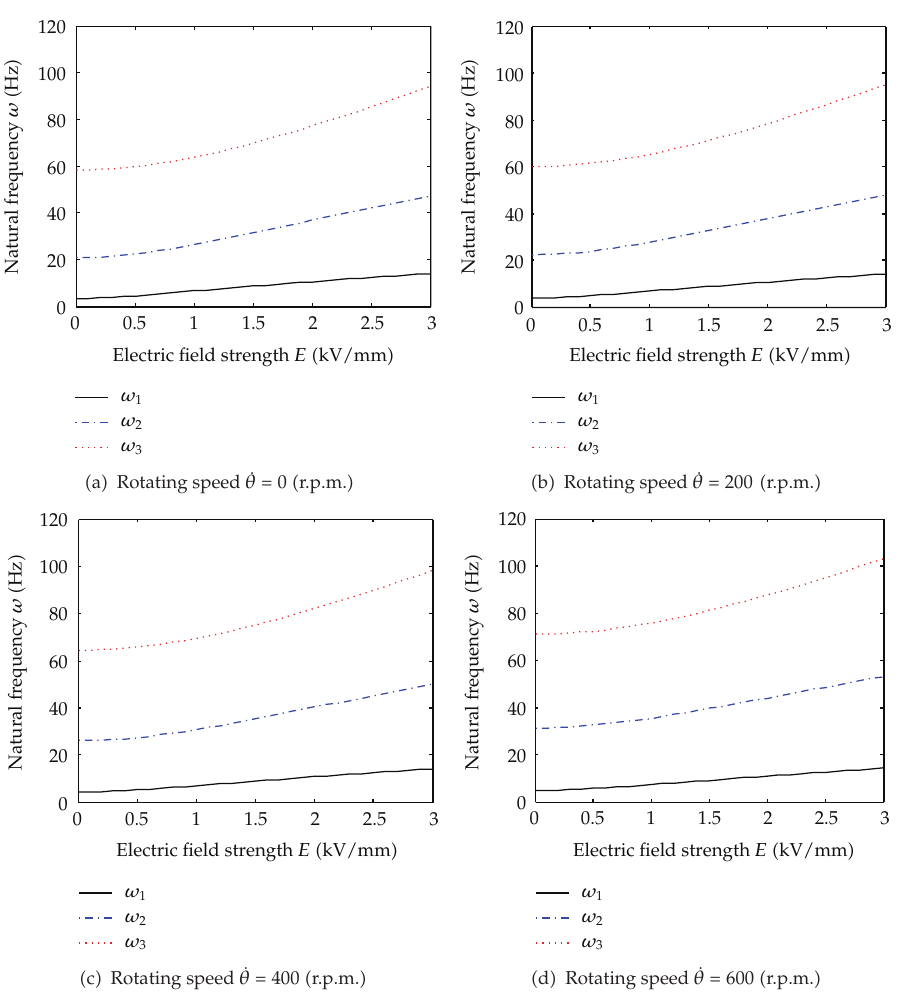
Figure 5: E ff ect of strength of electric field on the first three natural frequencies at di ff erent rotation speeds.